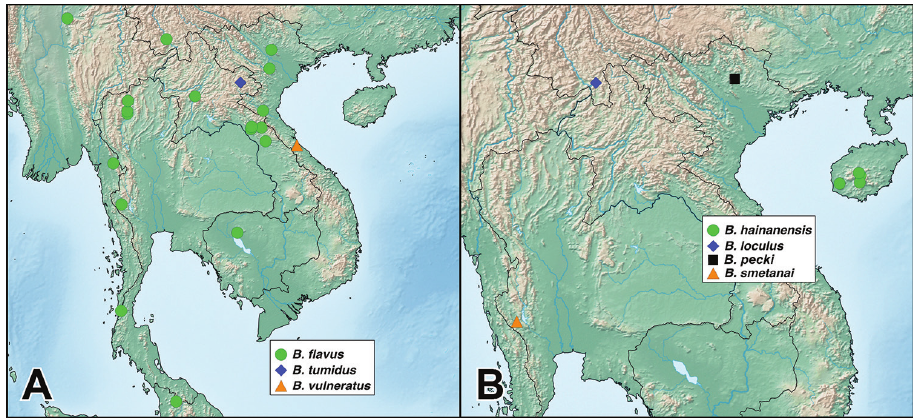
Figure 22. Distribution of: Bolitogyrus flavus Yuan et al., B. tumidus Brunke, and B. vulneratus (Fauvel) ( A ); B. hainanensis Cai et al., B. loculus Cai et al., B. pecki Brunke and B. smetanai Brunke ( B